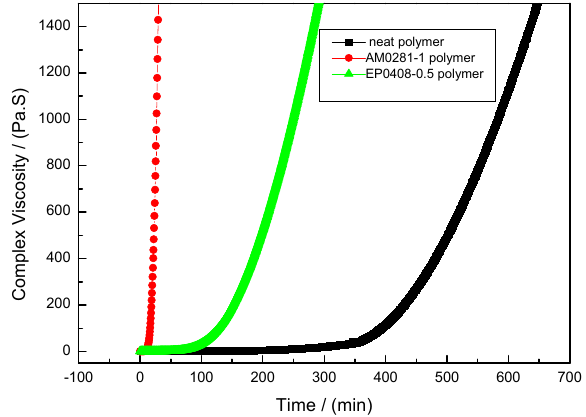
Figure 12. Complex viscosity at 280 °C as a function of time for the neat polymer, the EP0408-0.5 polymer, and AM0281-1 polymer.